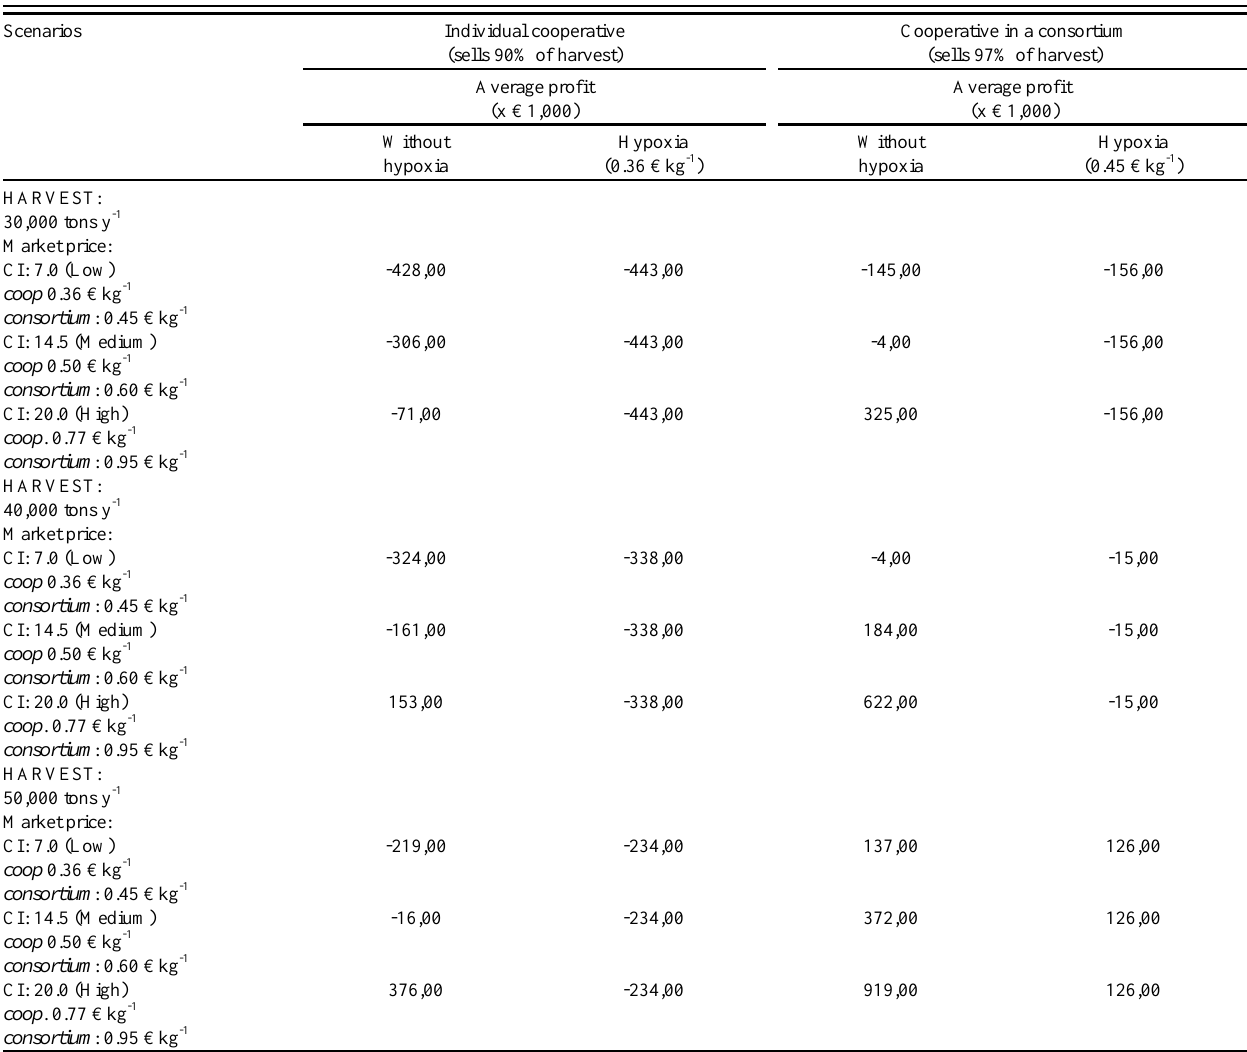
Table 6 . Comparison of the profit realized between an individual cooperative and a cooperative in a consortium when exposed to different environmental conditions: those controlling the mussel quality (condition index) and those blocking production (hypoxic events). A negative value for profit represents a